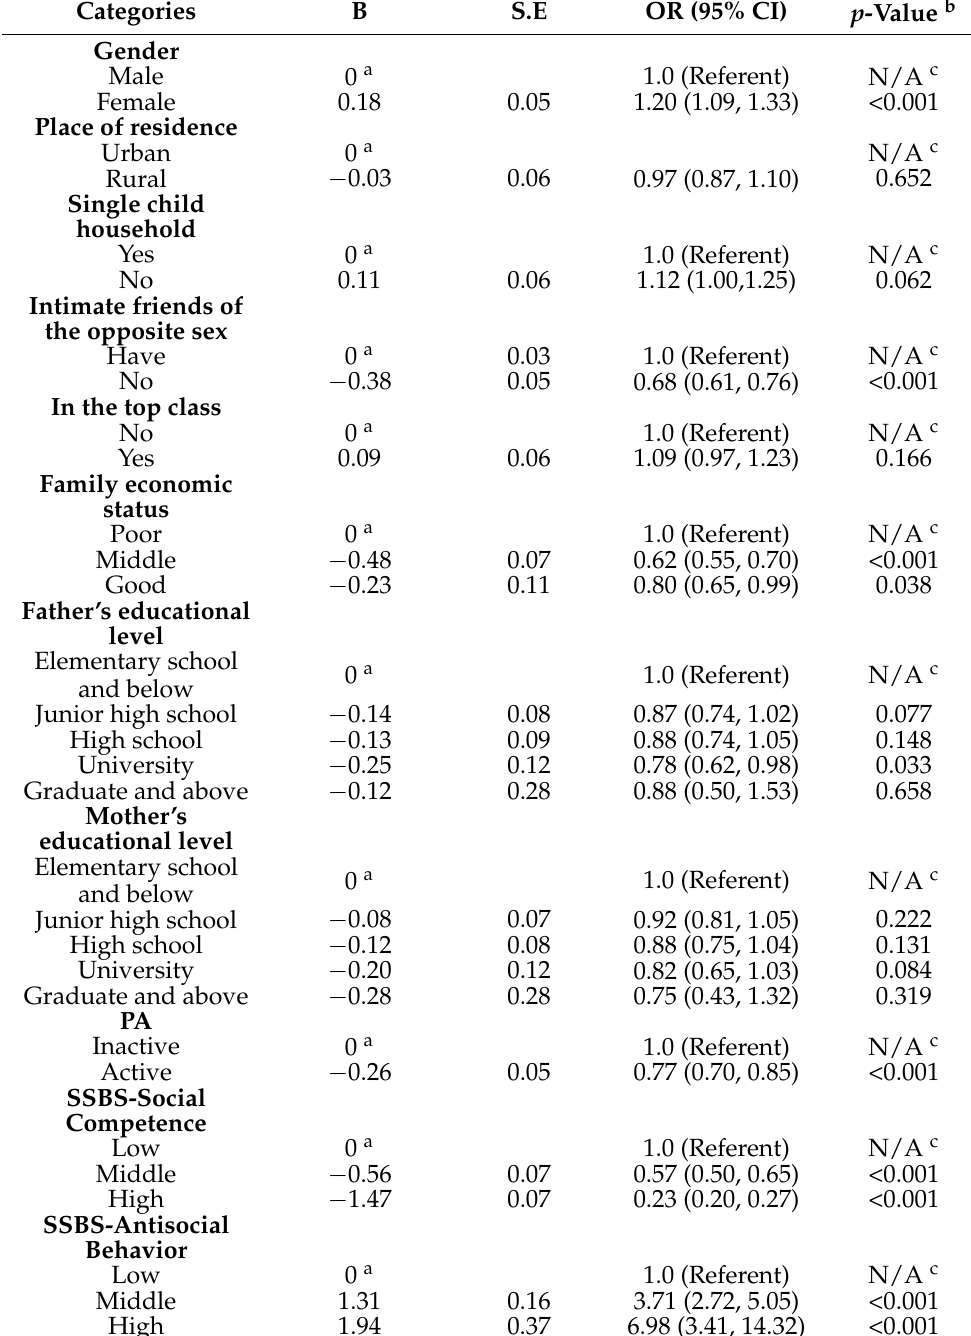
Table 3. Results of logistic regression analysis of factors that were associated with mental health